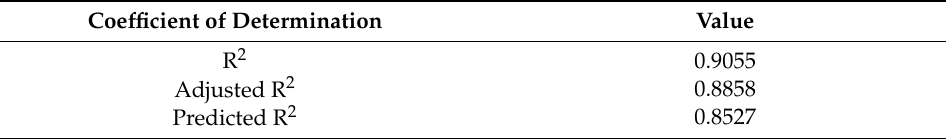
Table 13. Coefficient of determination for